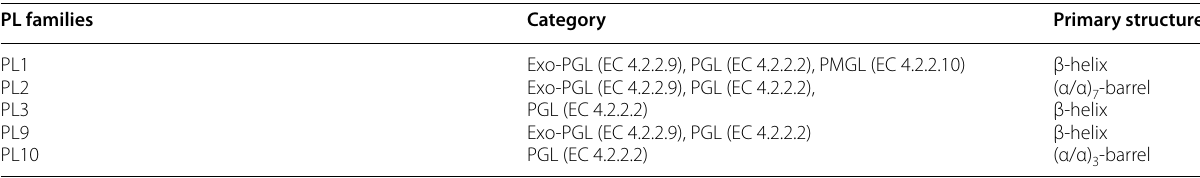
Table 3 Three-dimensional structures of PGLs and PMGLs in different PL families